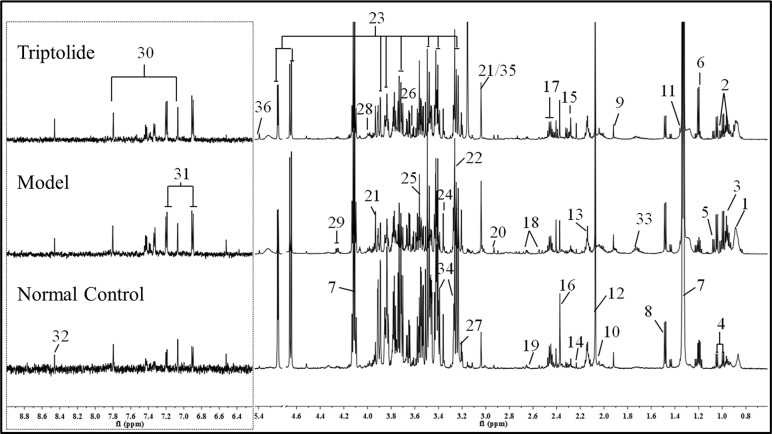
Representative 600 MHz 1H NMR spectra of plasma from normal control, model, and triptolide-treated groups. The following metabolites could be distinguished: (1) low-density lipoprotein (LDL); (2) isoleucine; (3) leucine; (4) valine; (5) isobutyrate; (6) 3-hydroxybutyrate; (7) lactate; (8) alanine; (9) acetate; (10) proline; (11) 2-hydroxyisobutyrate; (12) NAC1; (13) NAC2; (14) acetone; (15) acetoacetate; (16) pyruvate; (17) glutamine; (18) citrate; (19) methionine; (20) N,N-dimethylglycine; (21) creatine; (22) betaine; (23) glucose; (24) glycerophosphoylcholine; (25) glycine; (26) glycerol; (27) choline; (28) serine; (29) threonine; (30) methylhistidine; (31) tyrosine; (32) formate; (33) lysine; (34) taurine; (35) phosphate; and (36) allantoin.